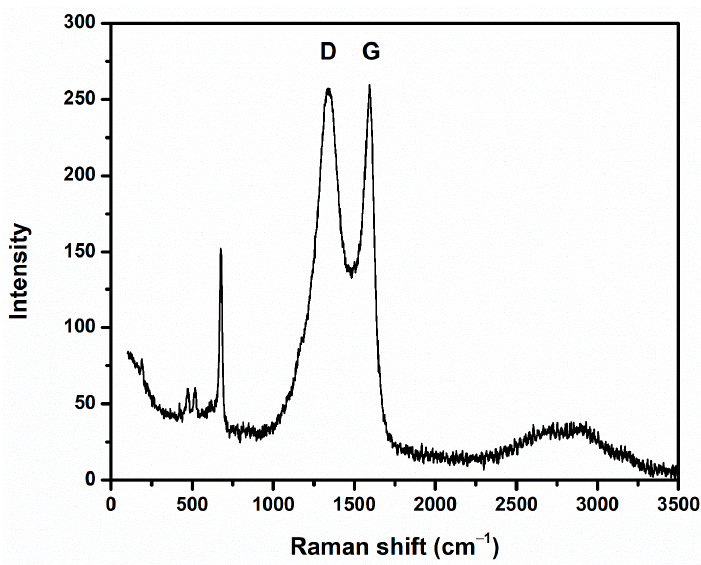
Figure 7. Raman spectrum of HPC-Co (1). XPS analysis of HPC-Co nanocomposite confirms the existence of three elements with atomic percentage, cobalt Co 2p 3/2 (3.99%), oxygen O 1s (24.83%) and carbon C 1s (71.18%), (Figure 8). High-resolution of C 1s is deconvoluted to four individual curves. The curve assigned to sp 2 hybridized carbon appears at 284.6 eV [46]. The three other signals appearing around 285, 286, and 289 eV are attributed to C − O /or amorphous carbon, C=O and COOH in the material surfaces, respectively [47,48]. It is noticeable that carbons with C − C bonds are predominant in HPC-Co, atomic percentage (36.89%), compared with other carbon groups C − O, O=C − OH and C=O which account for only 16.57%, 6.24% and 11.46%, respectively. In the deconvolution of O 1s spectra of HPC-Co, the peak located at 529.57